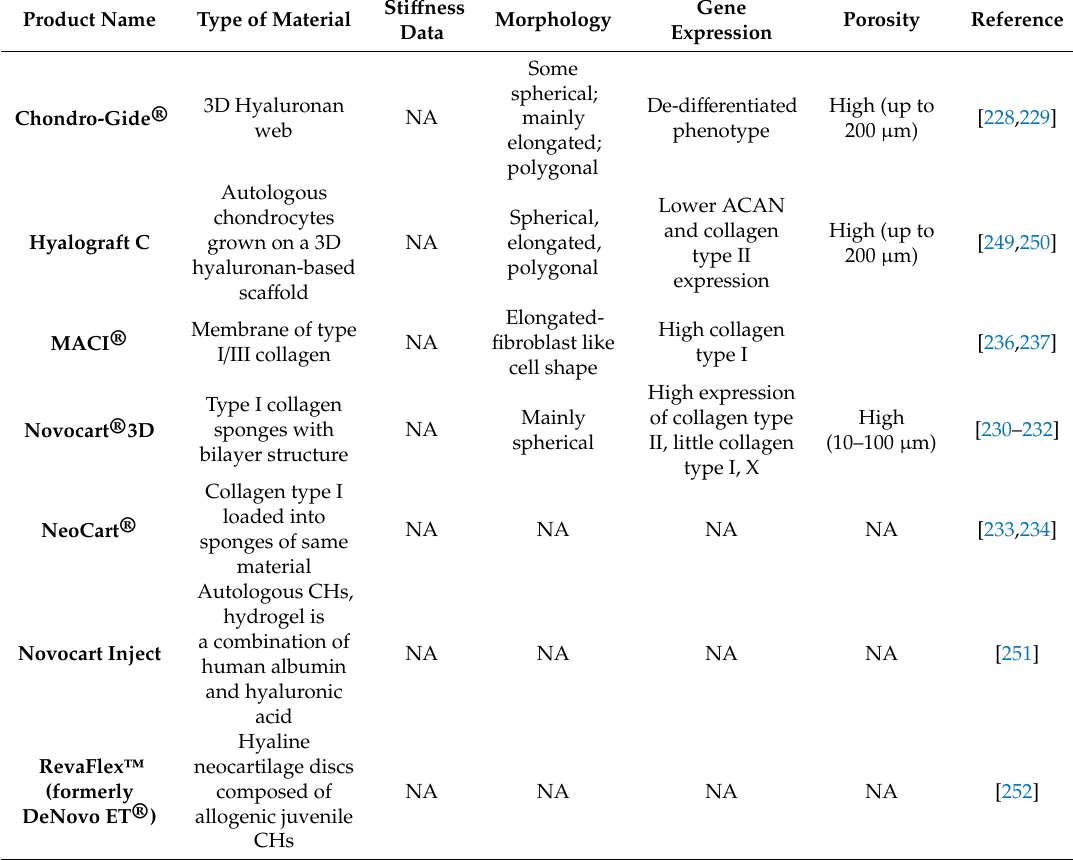
Table 1. Cell-based biomaterials used for clinical articular cartilage